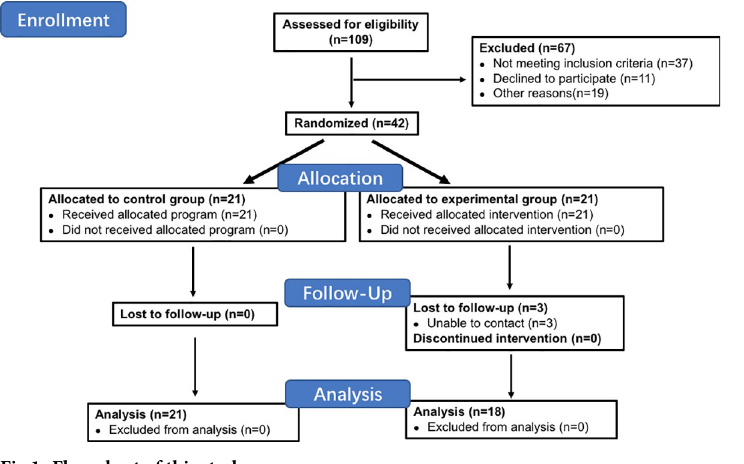
Fig 1. Flow chart of this